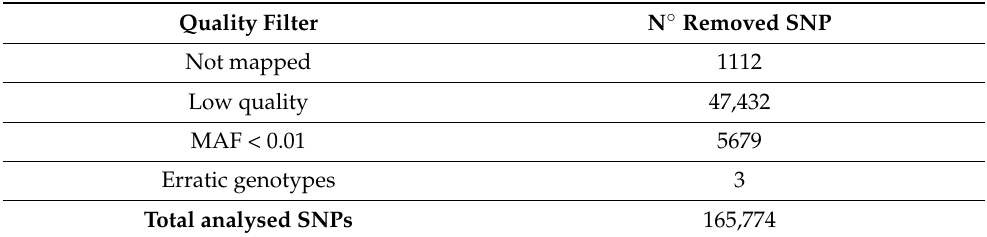
Table 1. Quality control was performed on a 220,000 customized array.